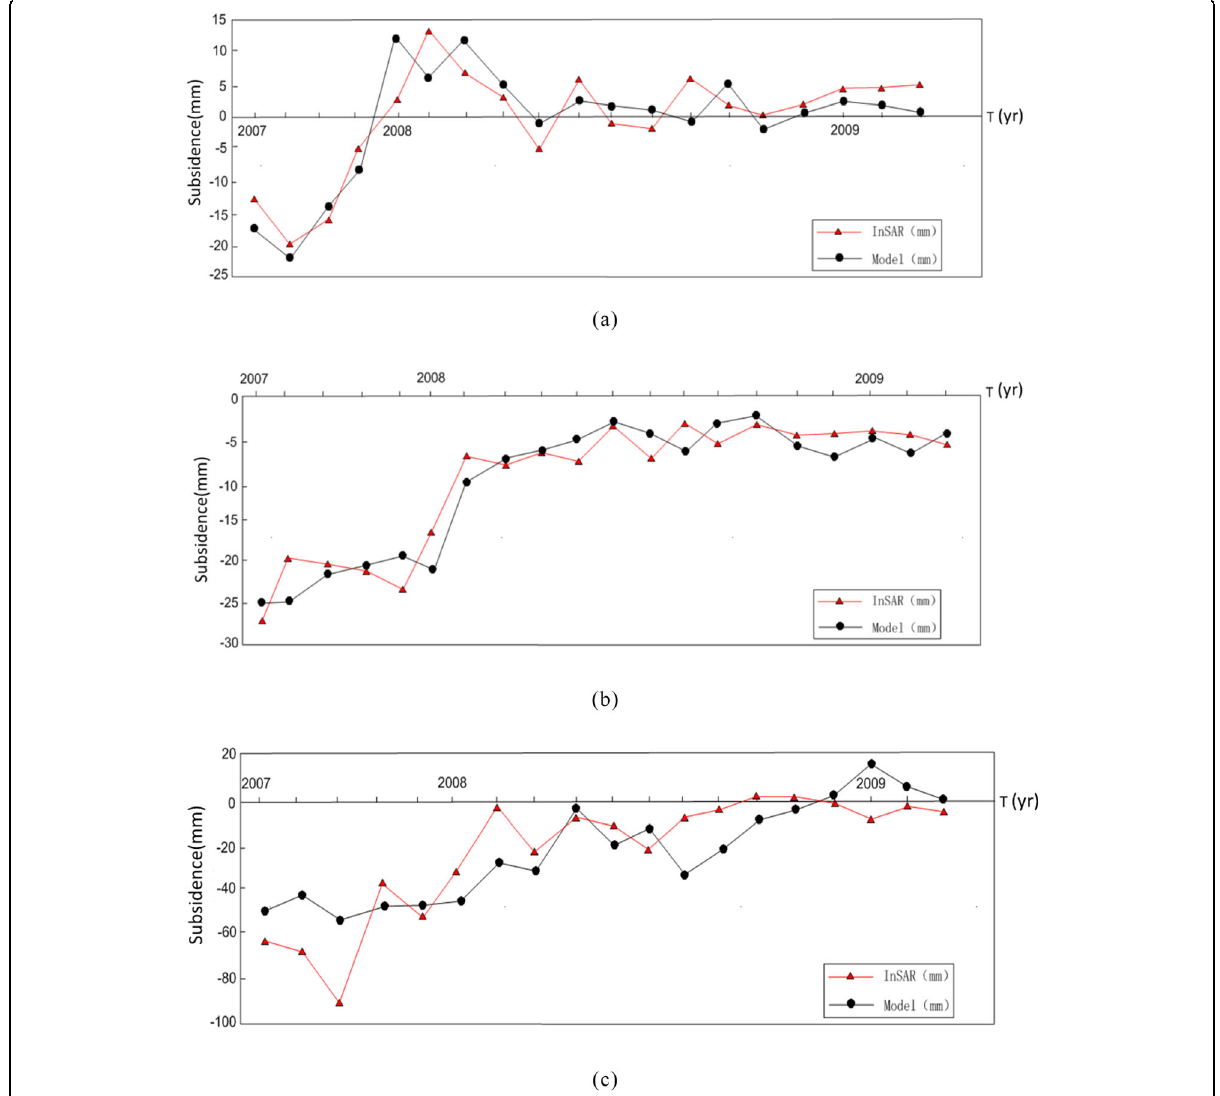
Fig. 20 Comparison curve of InSAR measured and simulated values at well site. a well site XI202, b well site 1038-2, c well site